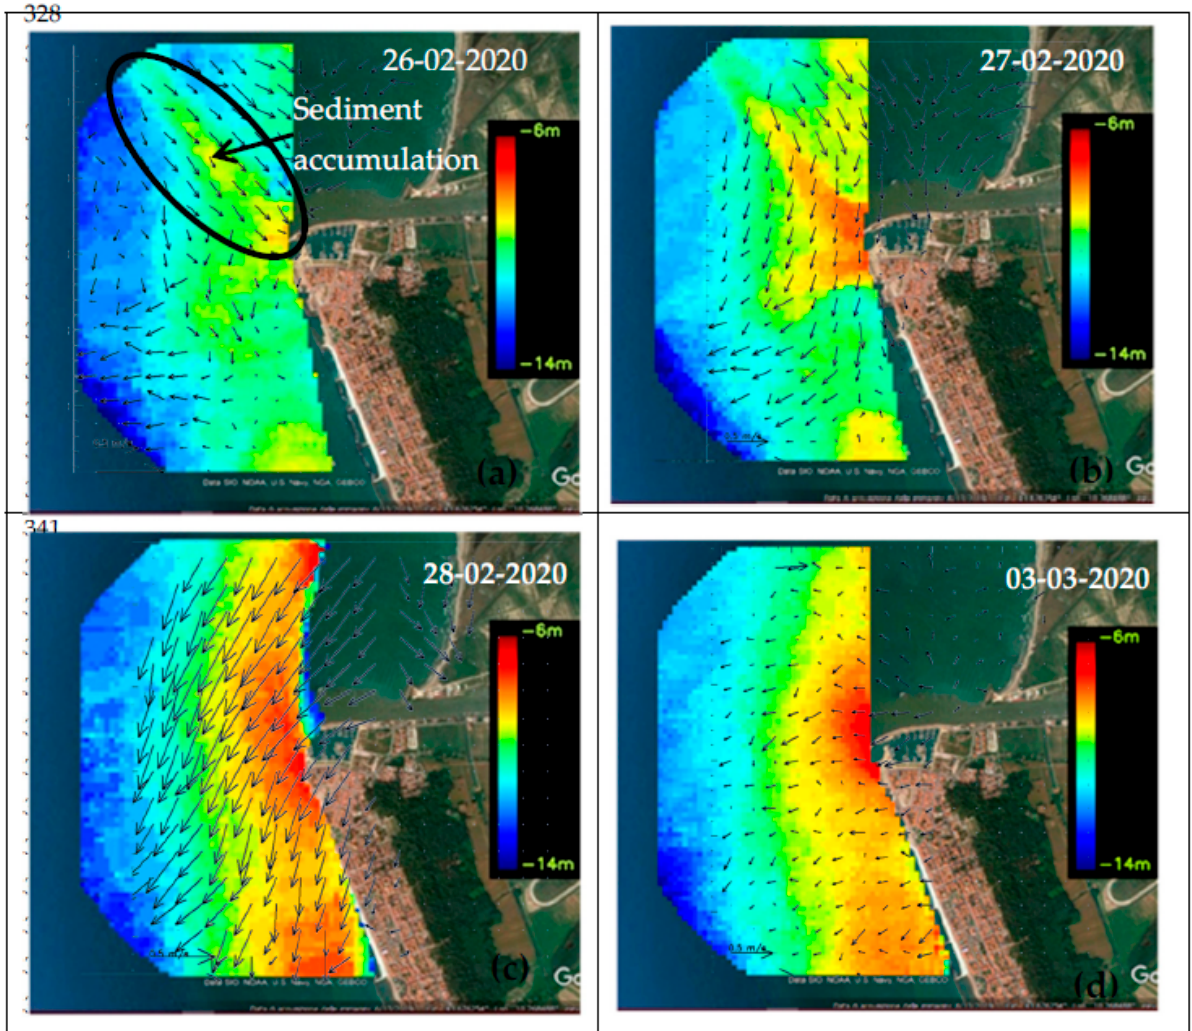
Figure 8. Surface currents overlaid to the bathymetry maps of 26 February ( a ), 27 February ( b )28 February ( c ) and 3 March ( d ), 2020, as surveyed and processed by the Remocean Coastal Monitoring system.